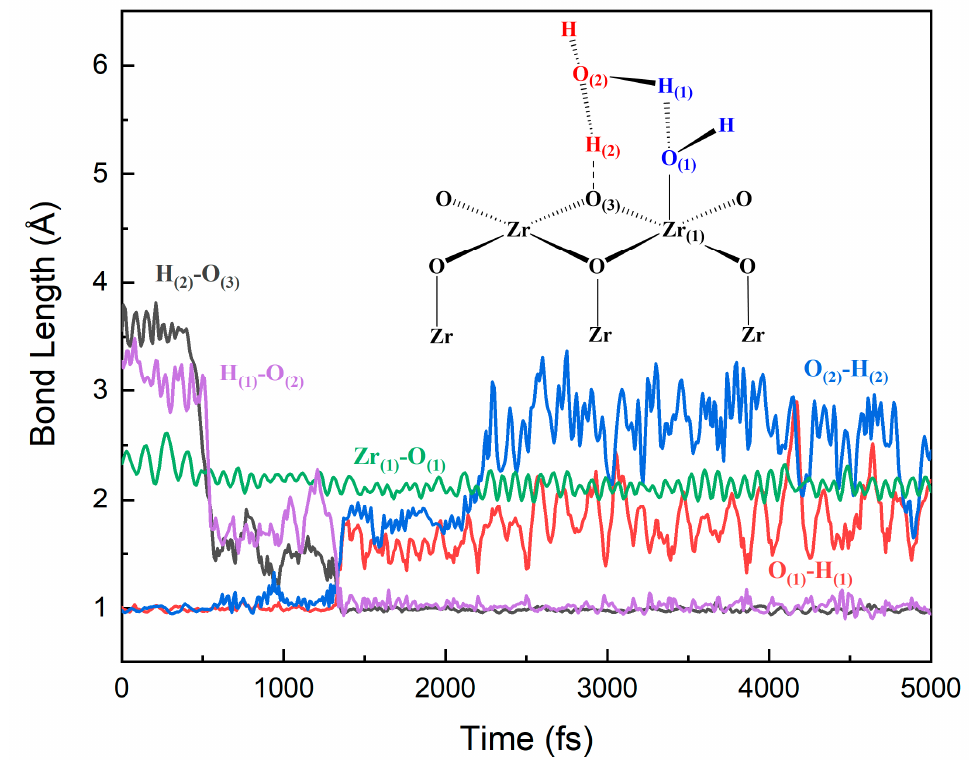
Figure 10. Evolutions of the bond lengths of O–H and Zr–O of two water molecules and the ZrO 2 interface reaction at site C .